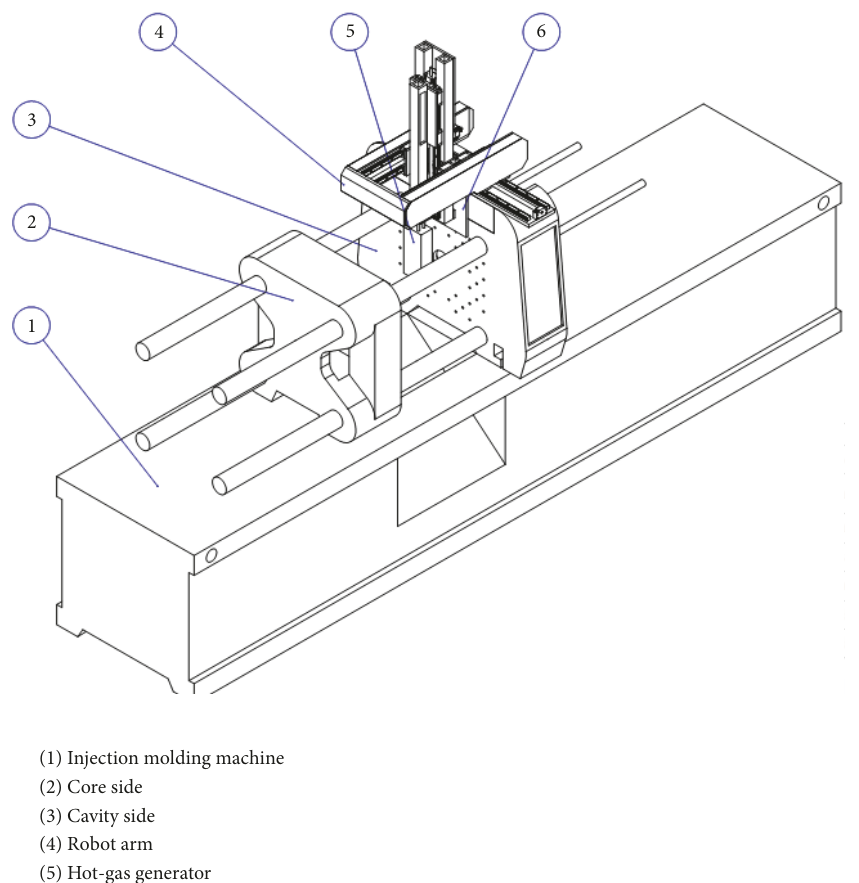
Figure 2: External gas-assisted mold temperature control heating